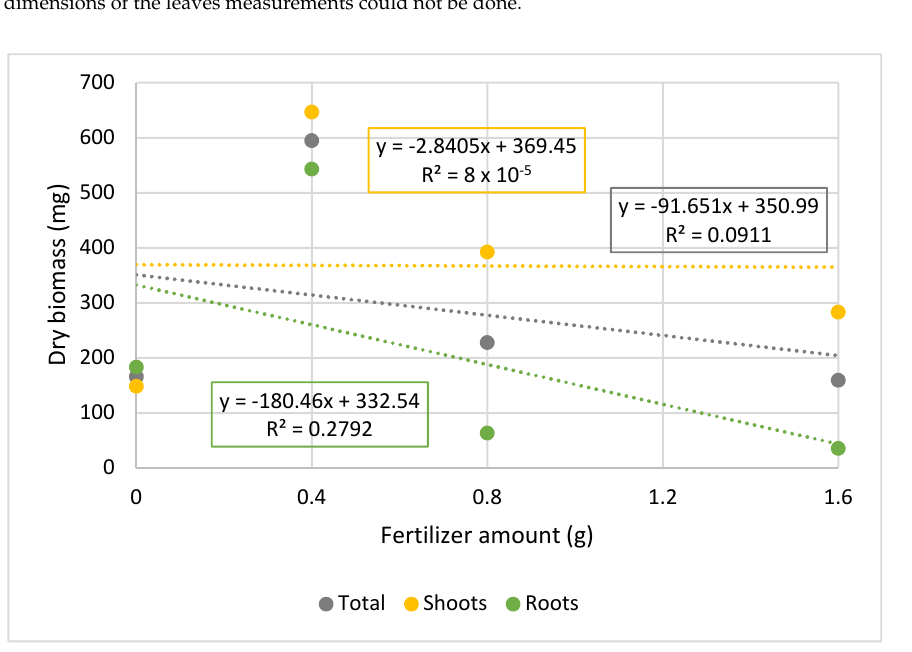
Figure 2. Linear regressions established between the dry biomass of the acclimatized tamarillo plants and the applied CRF doses.